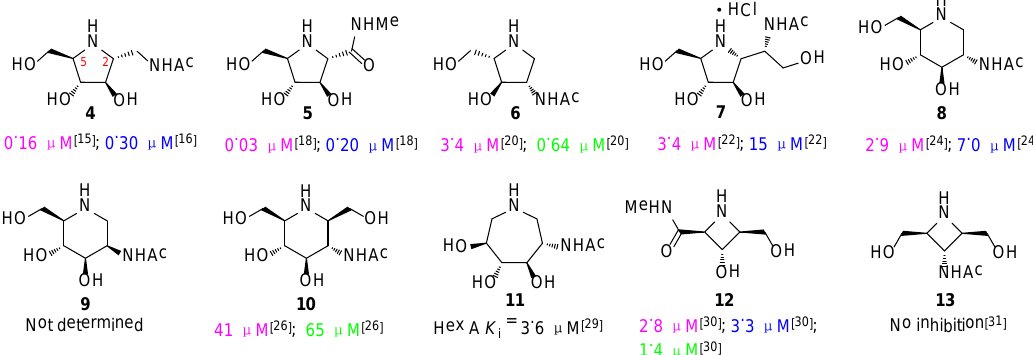
Figure 2. Examples of synthetic HexNAcase inhibitors.